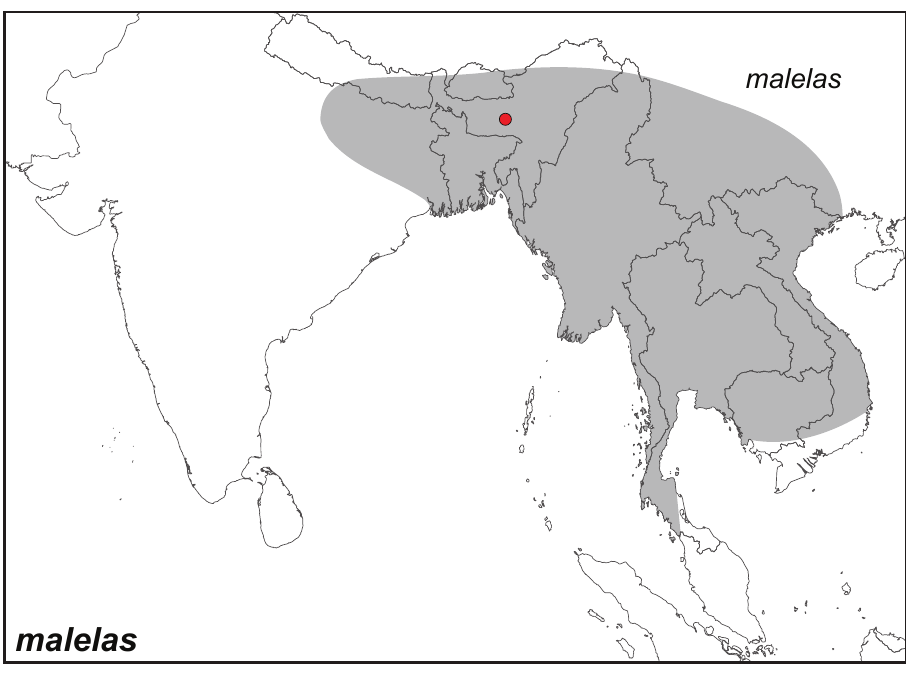
Figure 53. Distribution map of Elymnias malelas .